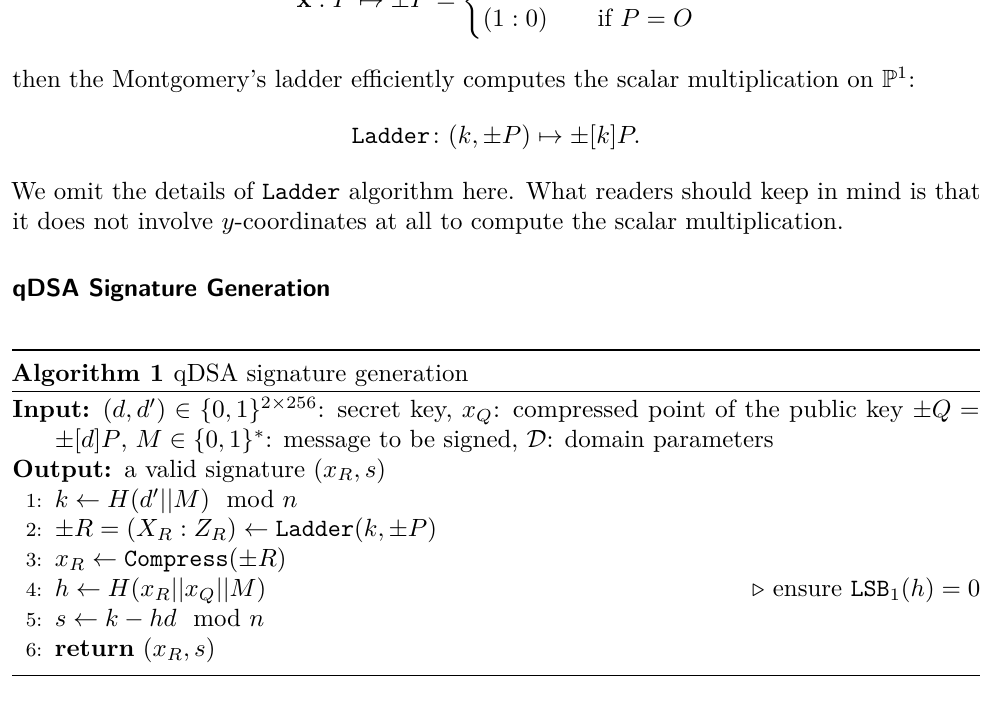
Algorithm 1 specifies the signature generation algorithm of qDSA. Here the